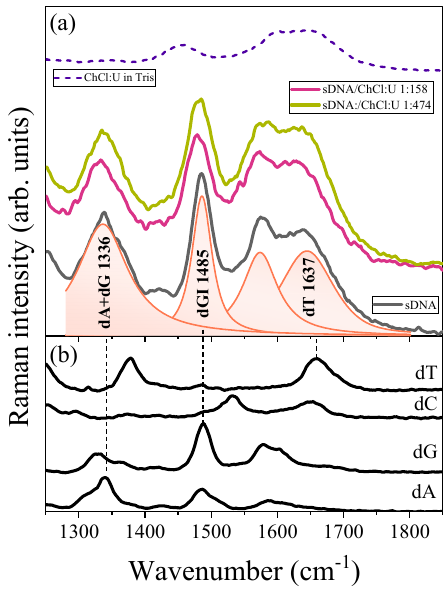
Figure 1. ( a ) 250 nm-excited Raman spectra of sDNA and sDNA/ChCl:U (1:158 and 1:474, respec- tively) collected at 300 K; the profile of the hydrated ChCl:U is reported for comparison in the same graph. ( b ) UVRR spectra of deoxynucleotides dA, dG, dC, and dT in a Tris buffer recorded using 250 nm as the excitation wavelength.